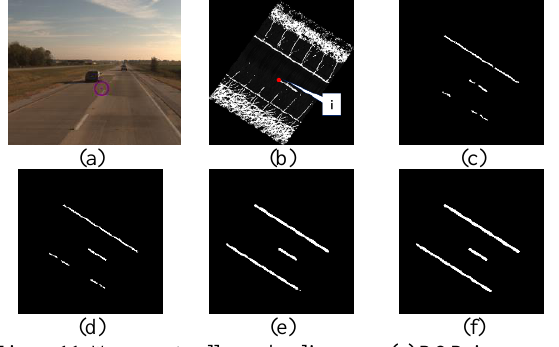
Figure 11. Worn-out yellow edge line area: (a) RGB imagery of location i, (b) original intensity image, predicted lane marking images of (c) original intensity thresholding, (d) normalized intensity thresholding, (e) U-net model 1, and (f) U-net model 2